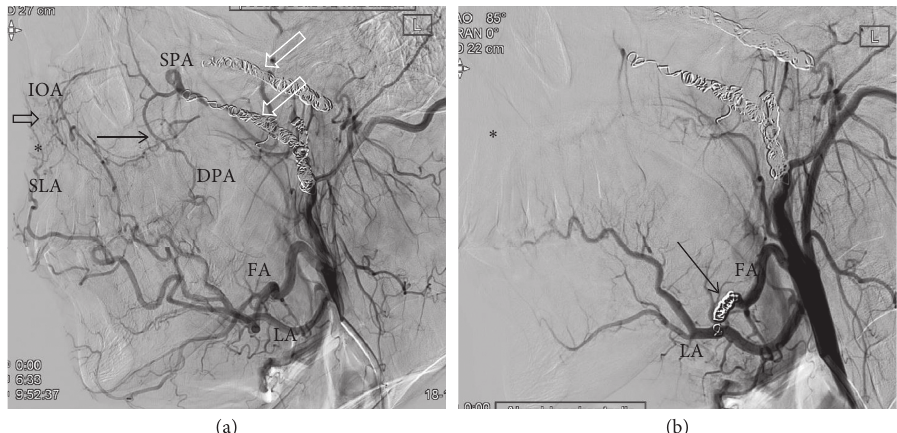
Figure 3: Embolization of left facial artery (FA) in a 25-year-old male patient with epistaxis and hereditary hemorrhagic telangiectasia having had a double-sided embolization 5 years ago. (a) Angiogram of the external carotid artery (ECA) shows coils in both SPA/IMA (right and left; white open arrows) after a successful double-sided embolization in 2014. Examination shows an extended collateral network via the facial artery (FA) in 2019. The collateral network consists of cross-connections of the superior labial artery (SLA)/infraorbital artery (IOA, open black arrow) and branches of FA/descending palatine artery (DPA, black arrow). (b) Coil embolization of FA was performed (black arrow). Control angiogram after embolization shows no significant contrast flow in the collateral network and Kiesselbach’s plexus. Also shown is the labial artery (LA).